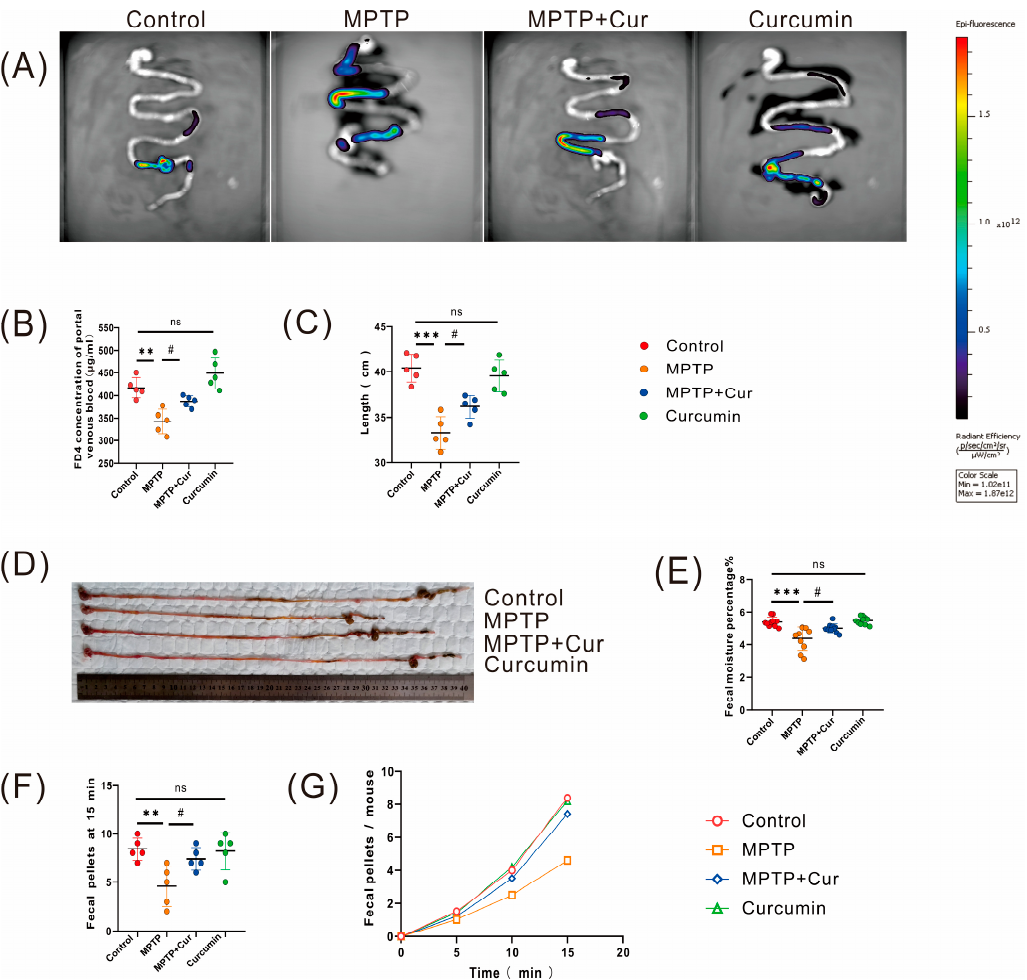
Figure 3. Curcumin treatment ameliorated MPTP-induced gastrointestinal dysfunction in PD mice. ( A , B ) Intestinal motility test ( n = 5/group): ( A ) representative image; ( B ) concentration of isothiocyanate–dextran in portal blood; ( C , D ) full-field anatomical images of the gastrointestinal tract of mice ( n = 5/group); ( E ) fecal water content ( n = 10 groups); ( F , G ) number of 15 min fecal pellets in mice; All statistical differences were tested using the t -test ( B , C , E , F ). Data are expressed as the mean ± SEM. Representative results are for one of the independent experiments.** p < 0.01, and *** p < 0.001 vs. control group. # p < 0.05 vs. MPTP group. n.s., not significant.